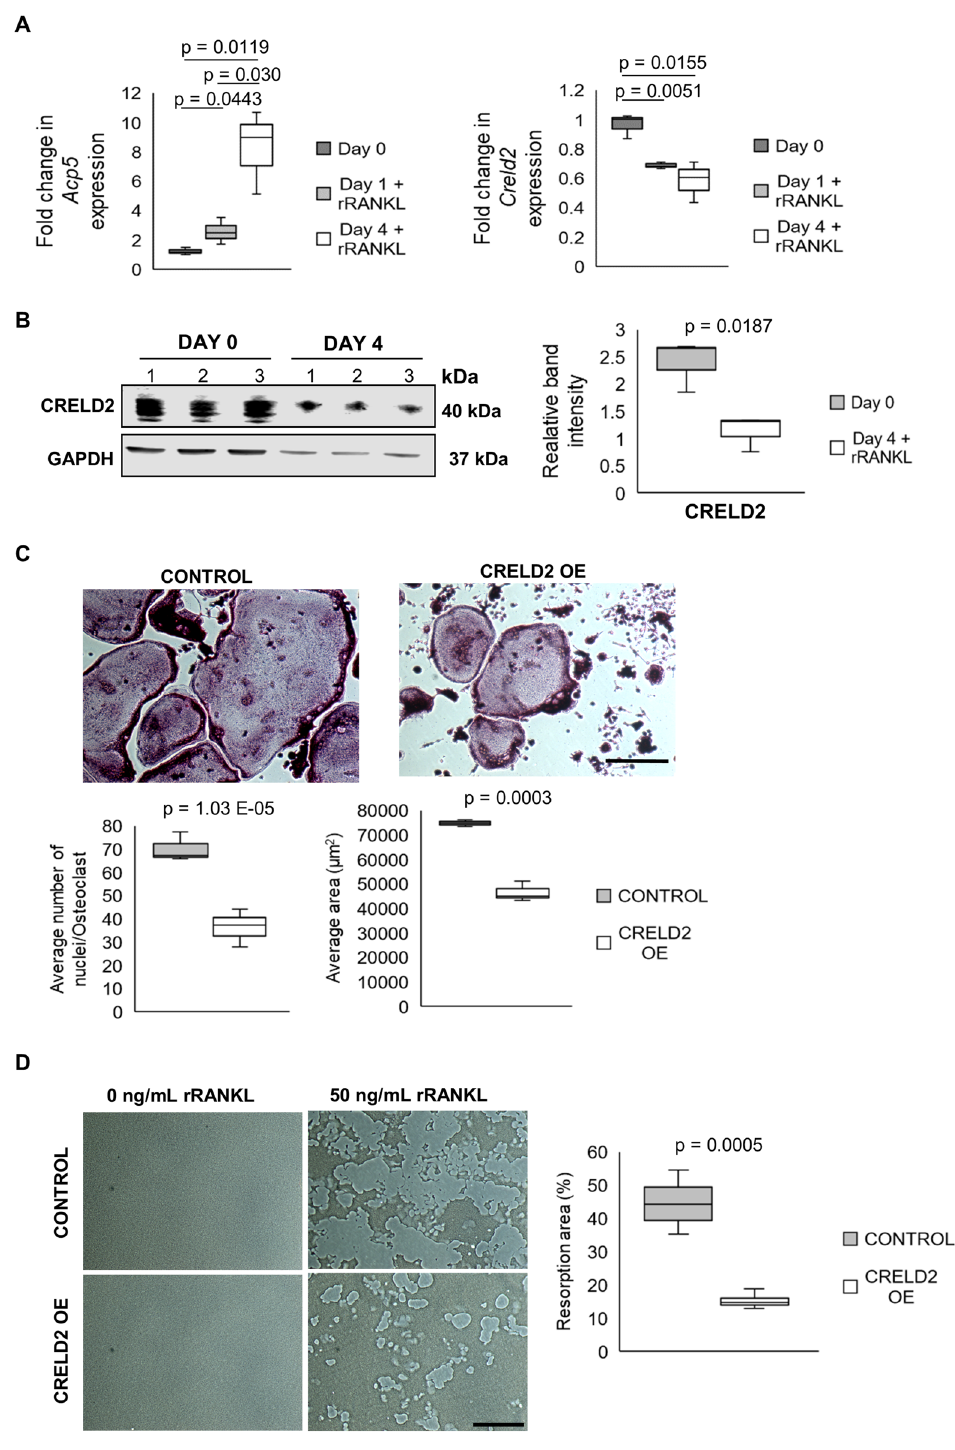
Figure 1. CRELD2 overexpression inhibits osteoclast differentiation. ( A ) qRT-PCR analysis of Acp5 and Creld2 expression in RAW264.7 cells pre and post treatment with recombinant RANKL (rRANKL). (n = 3 per condition). ( B ) Western blotting confirming CRELD2 is downregulated post treatment with rRANKL. (n = 3 per condition) ( C ) TRAcP staining and quantification of osteoclast area and number of nuclei/osteoclast 4 days after rRANKL stimulation. Scale bar = 200 µm. (n = 3 per genotype) ( D ) Resorption assay to assess osteoclast activity after 7 days stimulation with rRANKL. Scale bar = 200 µm. (n = 4 per genotype). Gene expression normalised to levels of Actb. Equal loading shown by GAPDH. Levels were determined by band densitometry. All graphs are displayed as mean ± standard deviation, significance denoted by p ≤